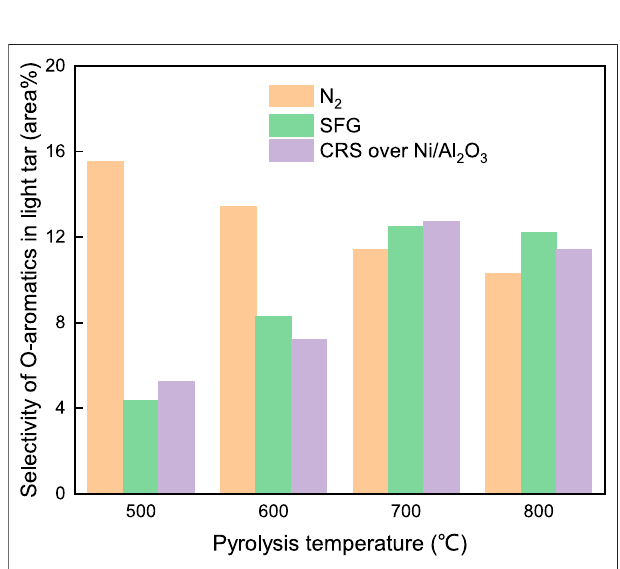
FIGURE 13 | The selectivity of the O-aromatic components under different